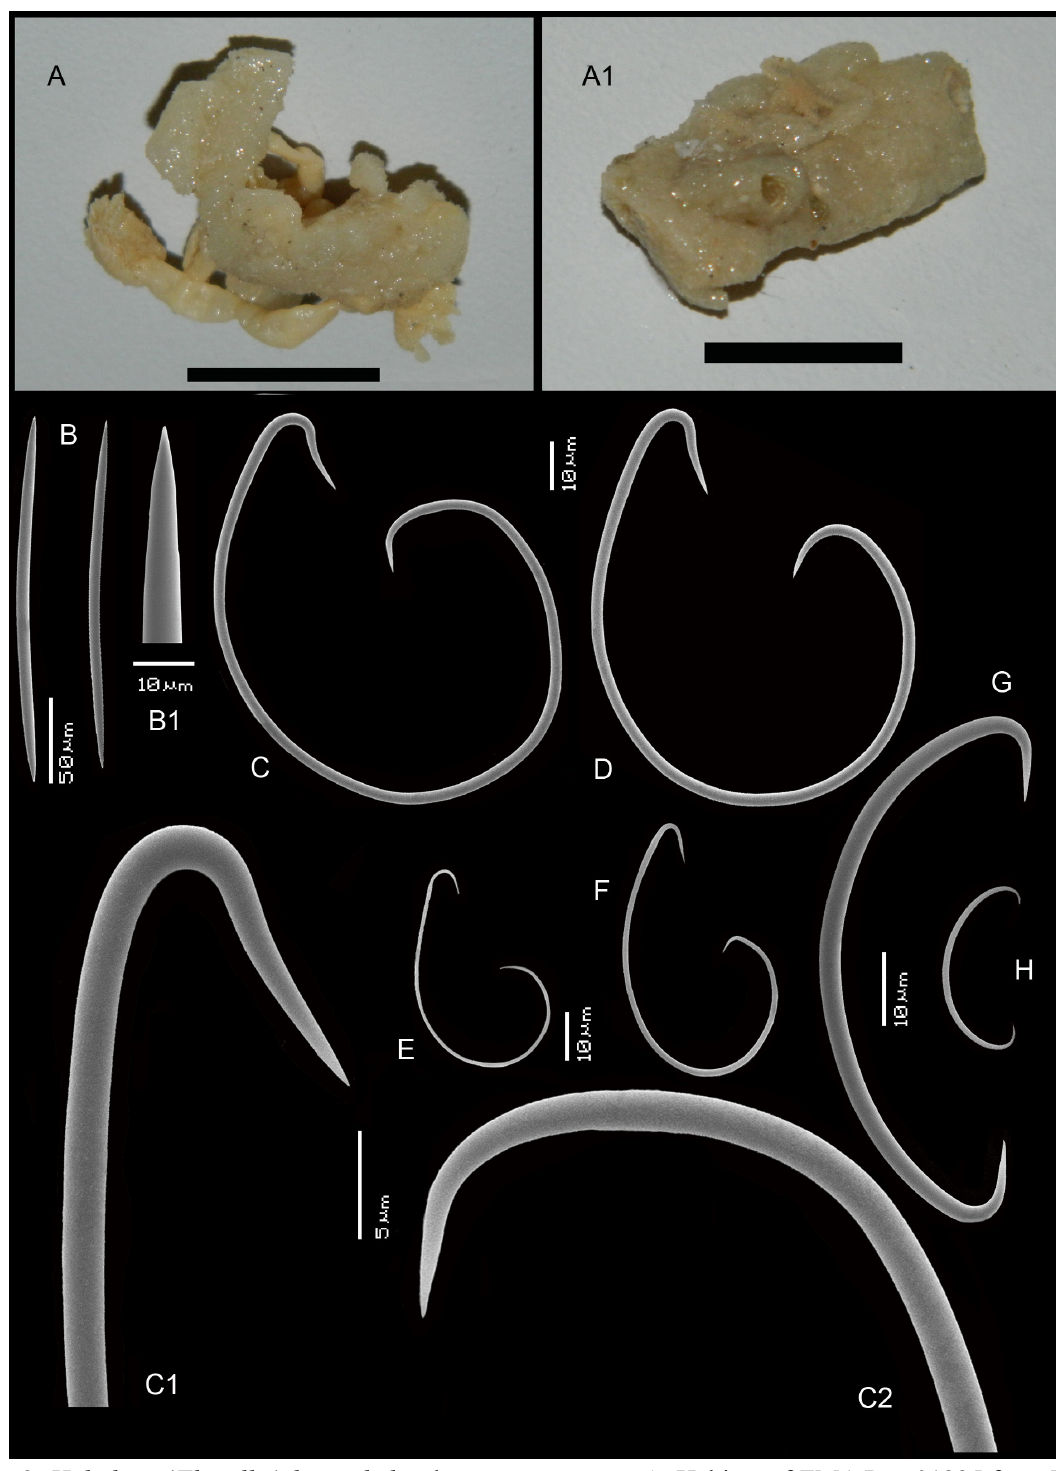
Fig. 9. Haliclona ( Flagellia ) hentscheli subgen. et nom. nov. A . Habitus of ZMA Por. 01225 from Tana Djampea, Kambarangi Bay, Indonesia (scale bar = 1 cm). A locality (scale bar = 1 cm). B–H . SEM images of spicules (ZMA Por. 01225). B . Oxeas. B of one of the apices. C–D . Large category (I) of flagellosigmas. C flagellosigma. C . Detail of short ending of large flagellosigma. E–F . Small flagellosigmas (II). G . Large 2 sigma category (I). H . Small sigma category